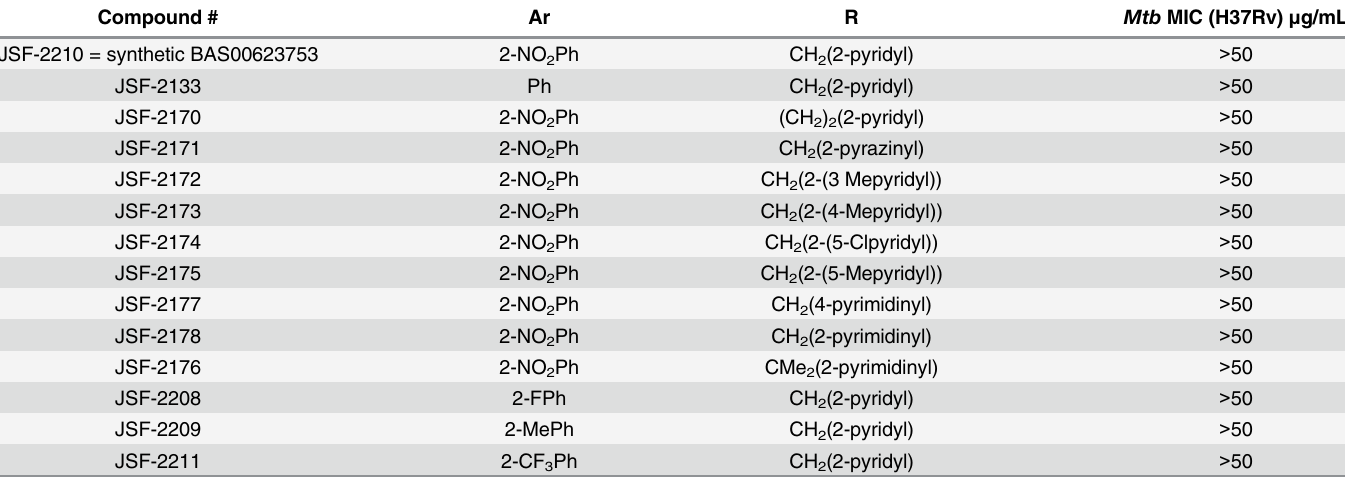
Table 1. Mtb growth inhibitory activities of BAS 00623753 and a small set of analogs. Molecule structures are in S1 Data.